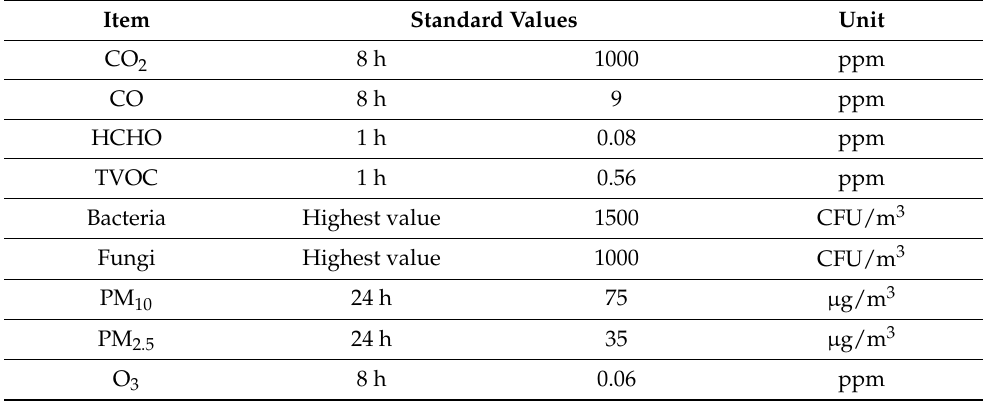
Table 3. Standard values of indoor air pollutants in